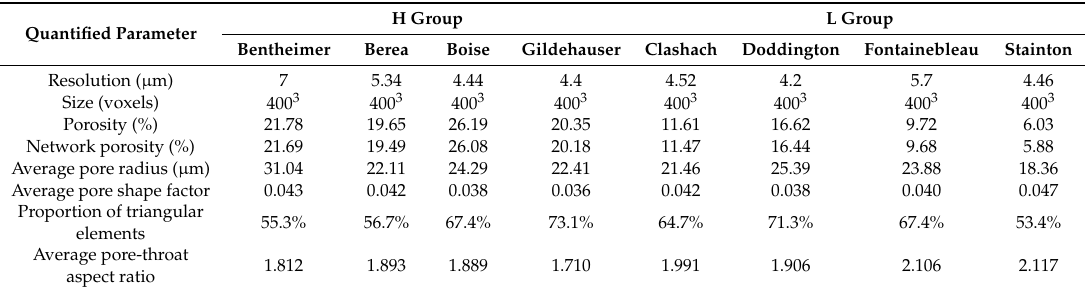
Table 1. The pore geometric properties based on the